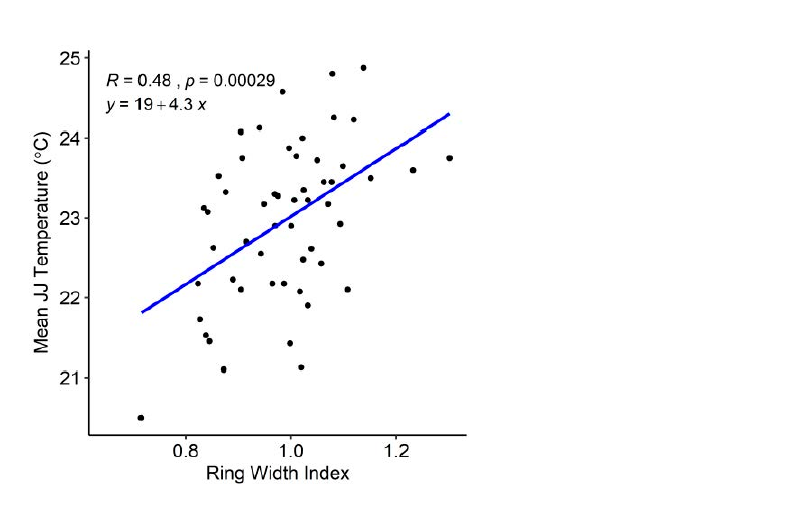
Figure 5. Correlation coefficients between radial growth of A. pindrow and monthly as well as multi-month combination temperature from current April to August (The horizontal tick labels show the current year months and monthly combinations from April-August and the asterisk marks * & *** above bars show statistical significance at p < 0.05 and p < 0.01, respectively).